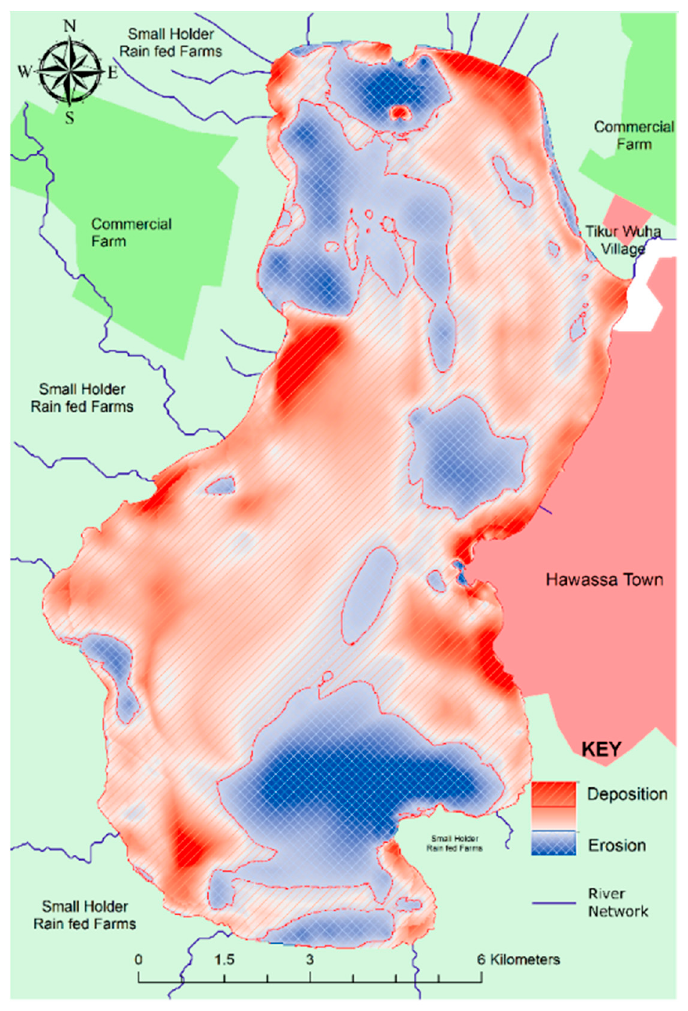
Figure 9. Lake Hawassa erosion and sediment deposition areas.